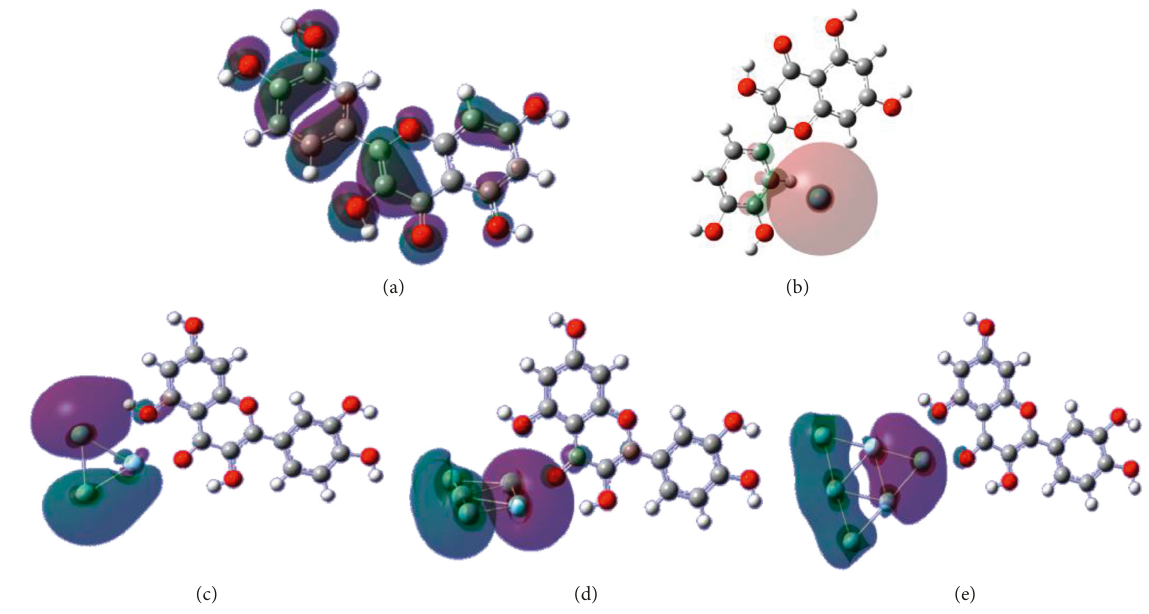
Figure 8: HOMO surfaces of (a) quercetin and the complex between quercetin with (b) a single silver atom, (c) cluster of 3 silver atoms, (d) cluster of 5 silver atoms, and (e) cluster of 6 silver atoms. the red shapes correspond to bonding molecular orbitals, while the green shapes correspond to antibonding ones.